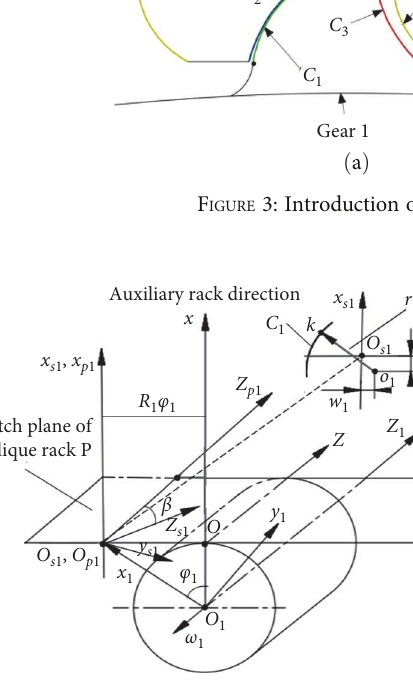
F IGURE 4: Schematic diagram of the gear 1 convex tooth surface